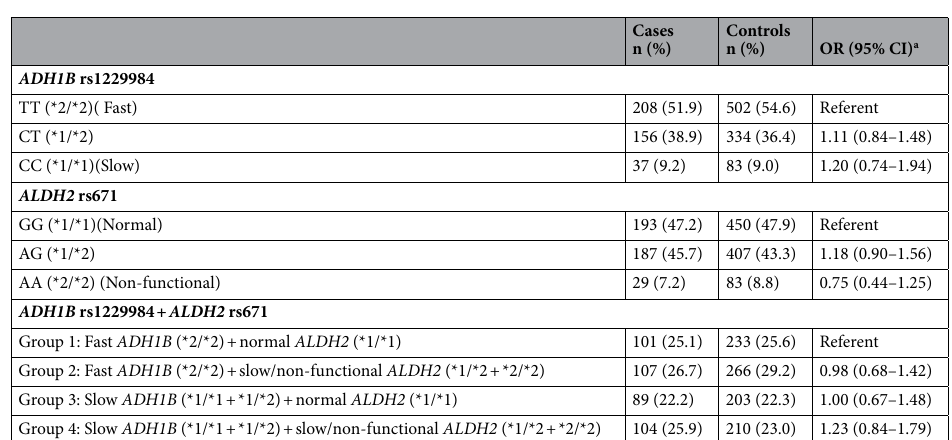
Table 4. The association between ALDH2 rs671, and ADH1B rs1229984 and pancreatic cancer risk. CI confidence interval, N number, OR odds ratio. a OR and 95% CI were calculated using unconditional logistic regression, adjusted for sex, age, education, cigarette smoking (pack-years), oral hygiene score, vegetable consumption, allergy, diabetes/glucose intolerance and BMI at two years before the pancreatic cancer diagnosis for the cases or before the interview date for the